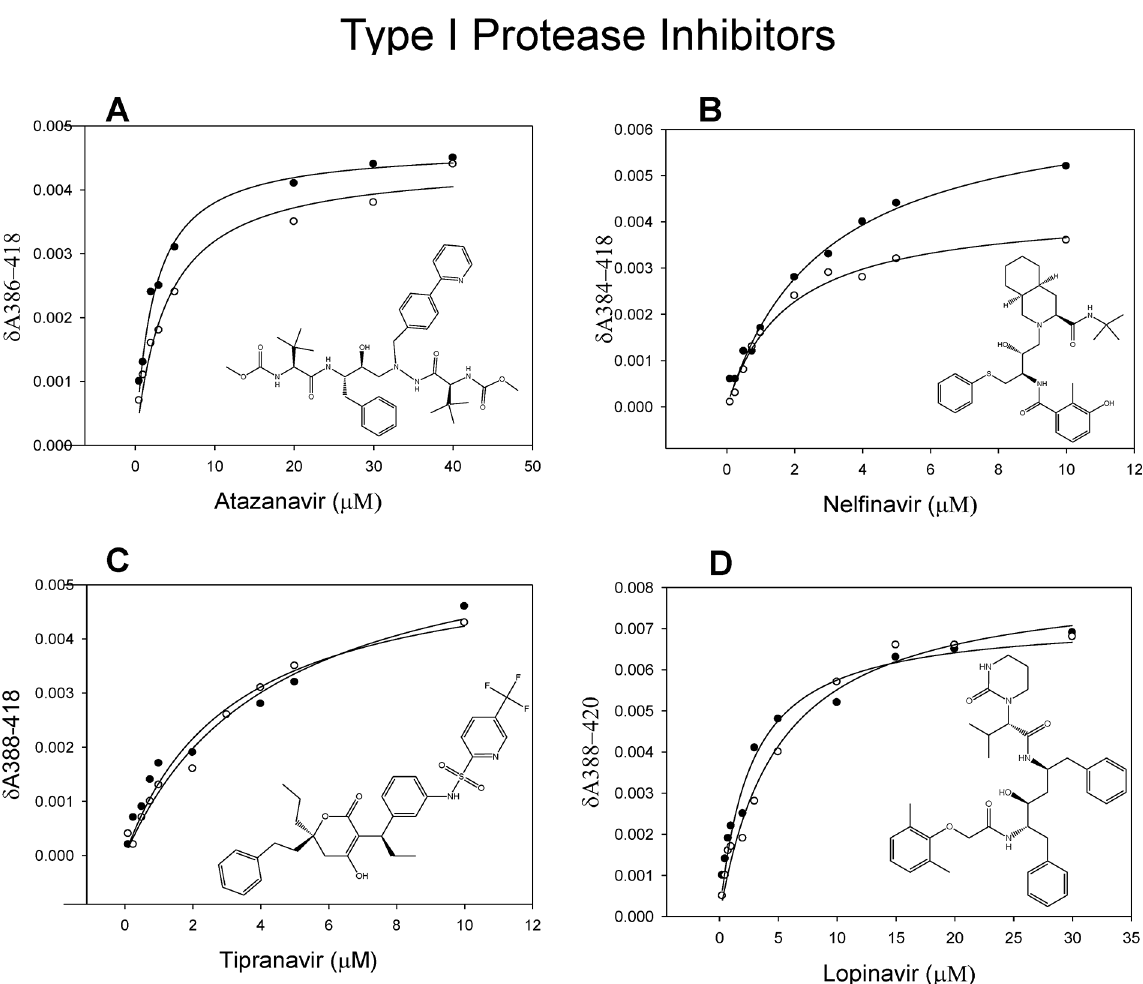
Fig 3. Spectral binding of type I PIs with CYP3A4 in the absence (filled circles) and presence (open circles) of methamphetamine. (A-D) The spectral binding was performed at varying concentrations of atazanavir, nelfinavir, tipranavir and lopinavir. The K D and δ A max for each PI with and without methamphetamine are presented in Table 2. One way ANOVA with Dunnet ’ s post-hoc test was employed to calculate the statistical significance. A p-value < 0.05 is indicated by * and < 0.1 is indicated by #.